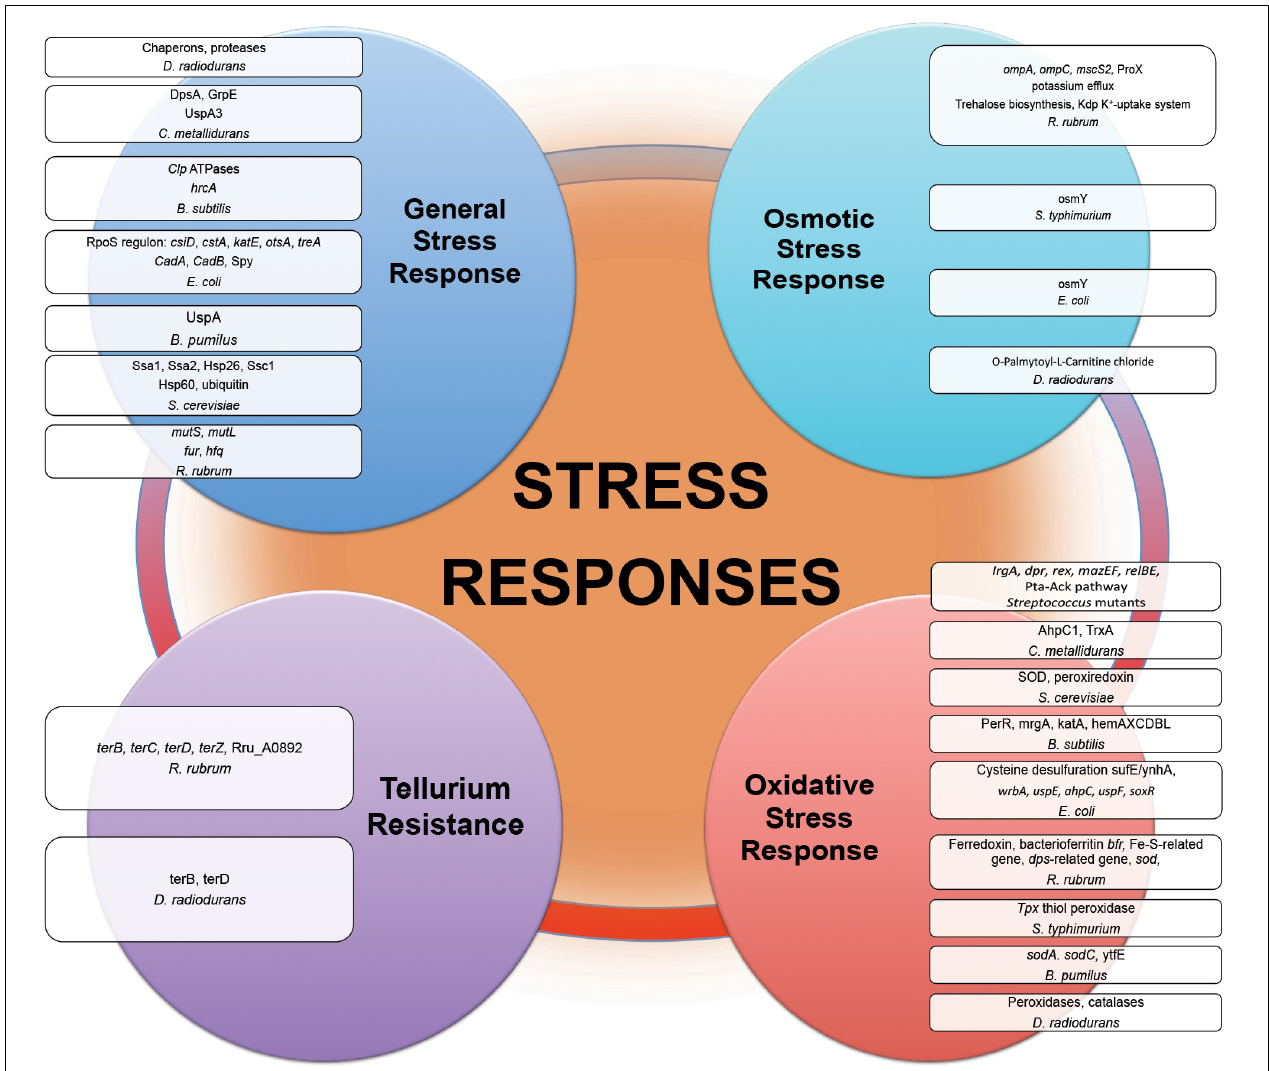
FIGURE 3 | Stress responses experienced by microorganisms in outer space real and simulated conditions. Proteins and genes of numerous stress responses with altered abundance and expression after exposure of microorganisms ( Table 1 ) to the outer space real and simulated